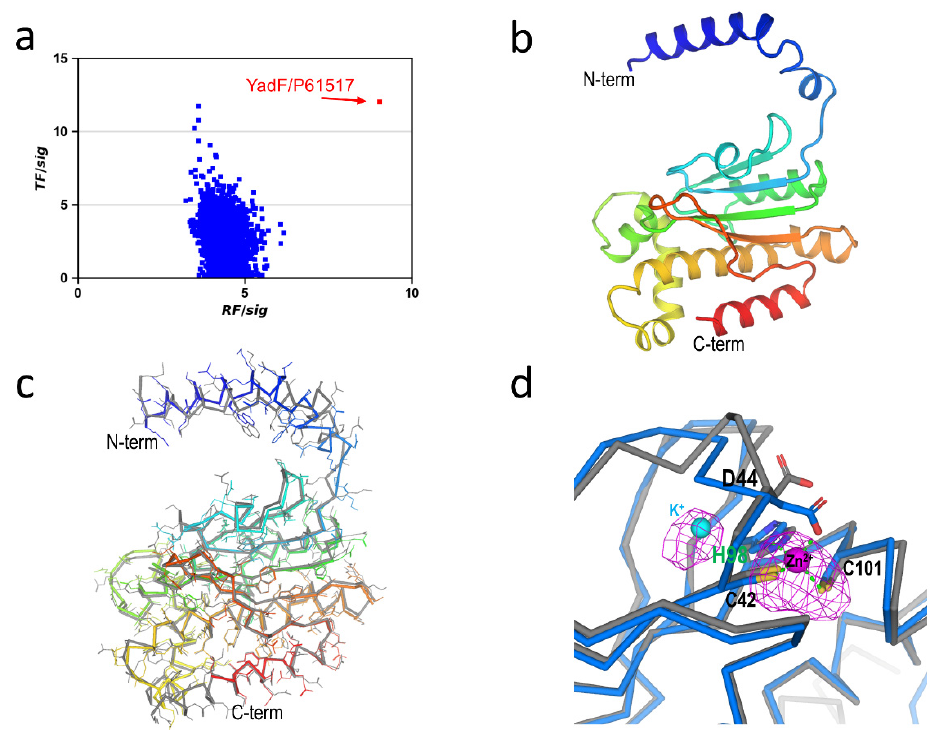
Figure 3. AlphaFold structures for phasing E. coli. YadF. ( a ) Histogram of rotation and translation peaks. ( b ) Refined YadF structure. ( c ) Comparison with the AlphaFold structure. The AlphaFold- predicted structure is shown in gray. ( d ) Active-site structure. Residues interacting with the zinc site are shown as sticks. Bijvoet difference Fourier map for anomalous scatterers were shown as magenta isomeshes contoured at 3 σ . As a comparison, the AlphaFold-predicted structure is shown in gray.